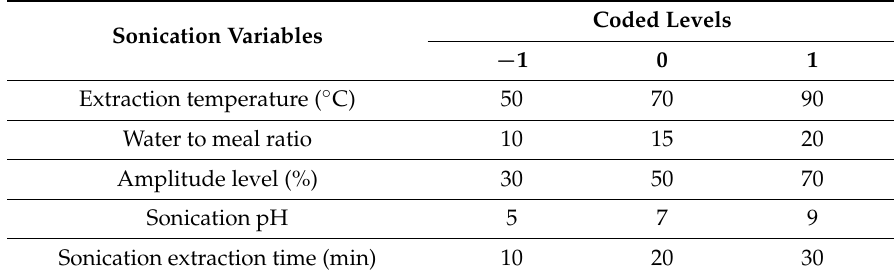
Table 1. Coded and actual levels of independent variables for optimization of flaxseed-derived polysaccharide gums (PSG) yield as determined by the Box–Behnken